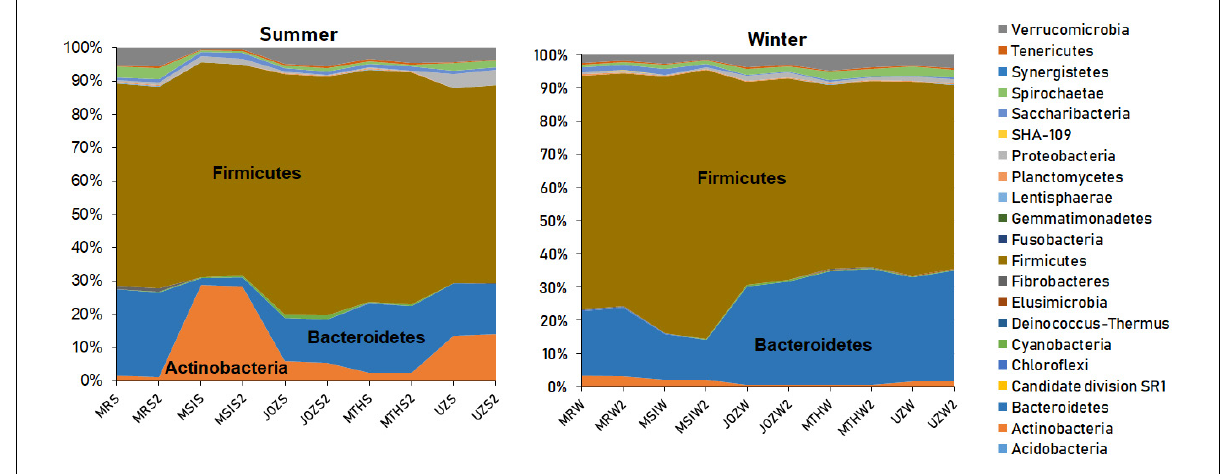
Figure 4: Relative abundance of bacterial phyla of Zulu sheep in summer and